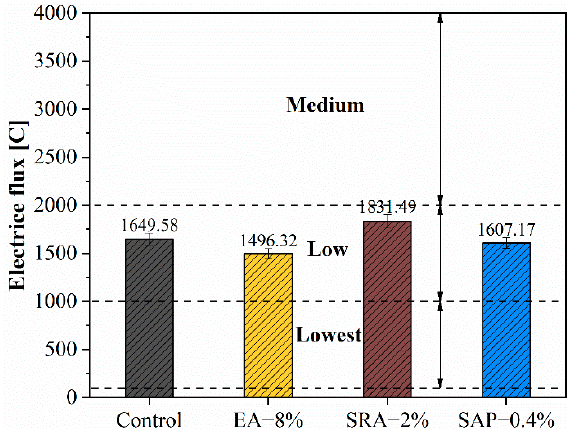
Figure 11. Influence of the electrical flux of concrete with the different shrinkage-reducing compo- nents.